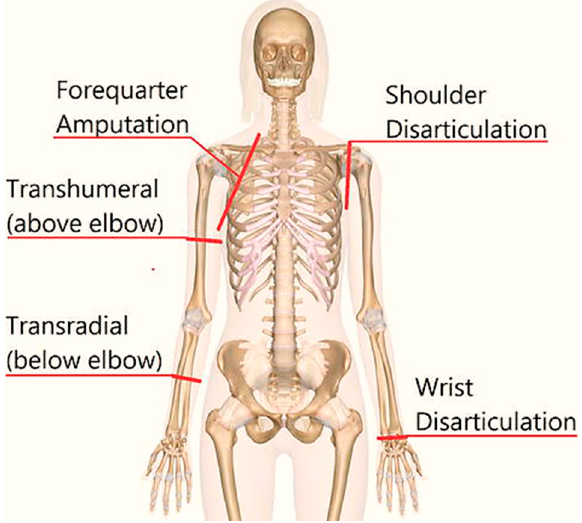
Figure 1. Levels of upper limb amputation [3].